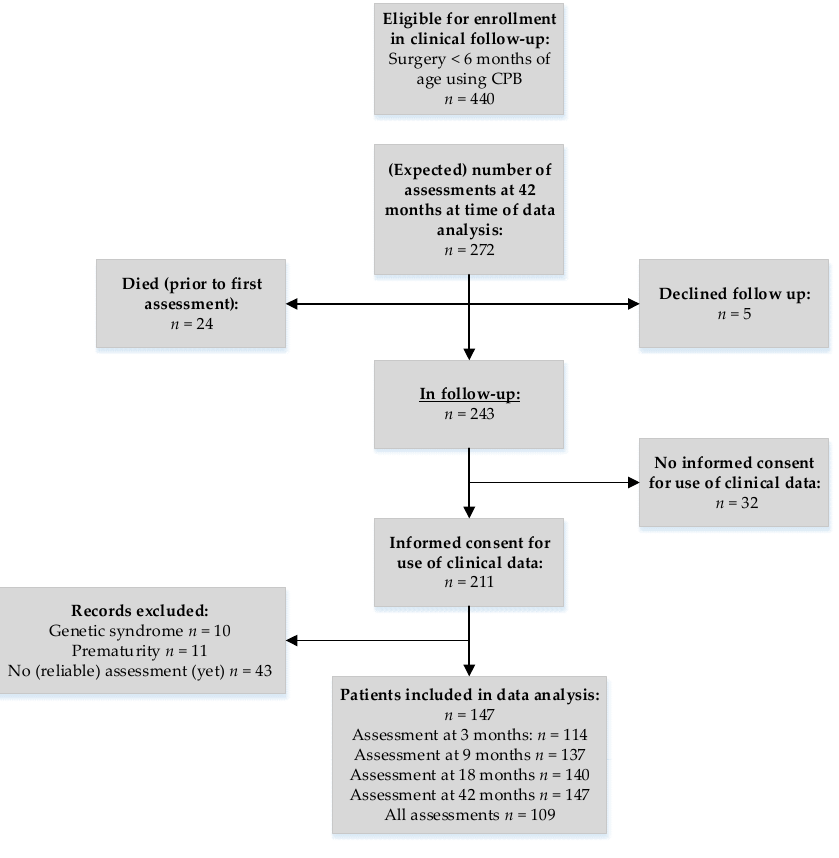
Figure 1. Flowchart enrollment in follow-up.